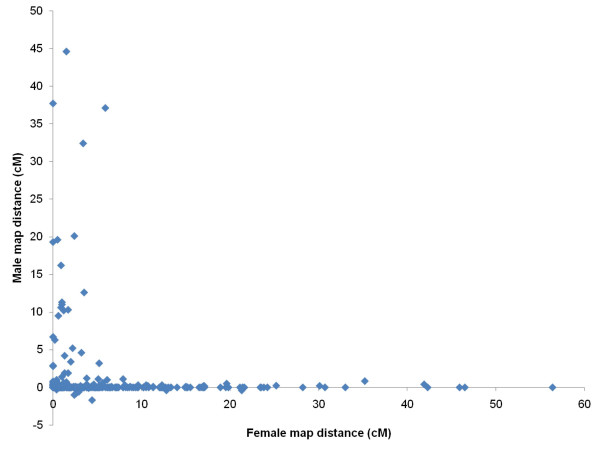
Male and female recombination rates for pairs of adjacent markers (d09a to s17b). Only markers on linkage groups with a 1-to-1 relationship between the male and female homologue were considered (i.e. linkage groups 17 and 21 were excluded).